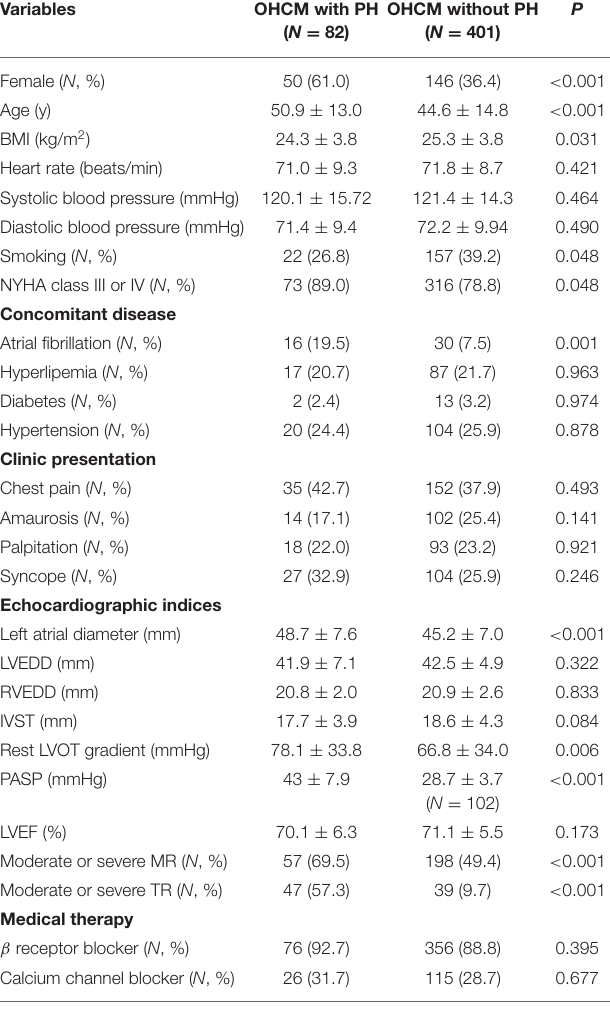
TABLE 1 | Baseline characteristics of the study